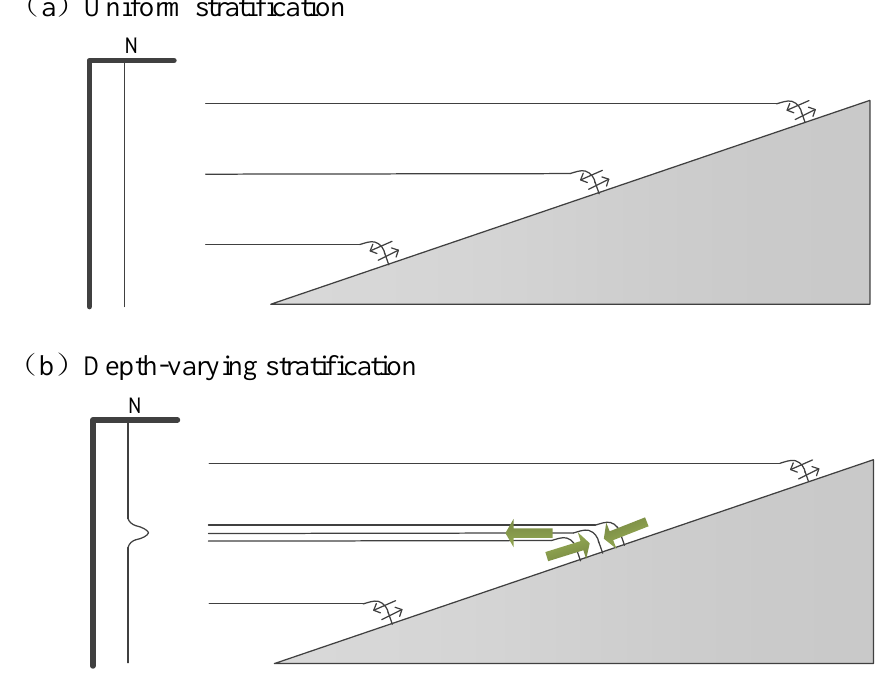
Figure 6. Development of boundary layer flows when mixing in a stratified fluid is confined to a mixing layer above a sloping boundary [39]. ( a ) Uniform stratification; ( b ) stratification varies with depth and a pycnocline intersects the sloping boundary. Thin arrows are isopycnals to spread in this region. Thick arrows indicate that convergence pushes mixed fluid out of the boundary layer and the mixed fluids spreading along the pycnocline.